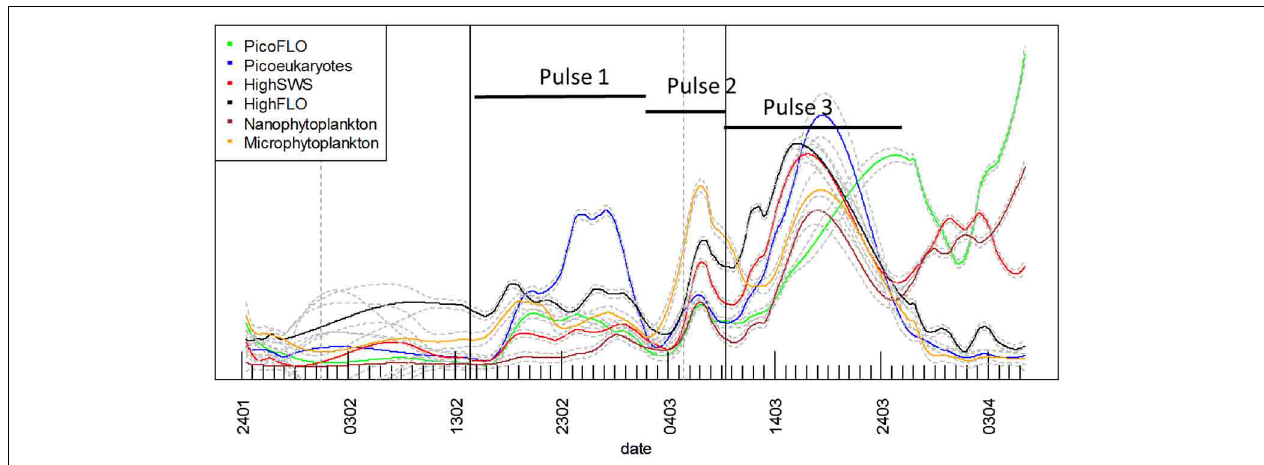
FIGURE 7 | Superimposition of each cluster’s predicted loess results derived from the raw abundance time series. All three different abundance pulses involved all phytoplankton clusters. The abundances of the different clusters are not represented to scale on the Y-axis for the sake of clarity (see